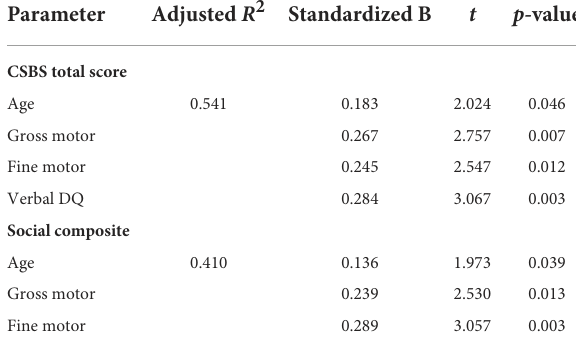
TABLE 6 Linear regression model of CSBS total score and social